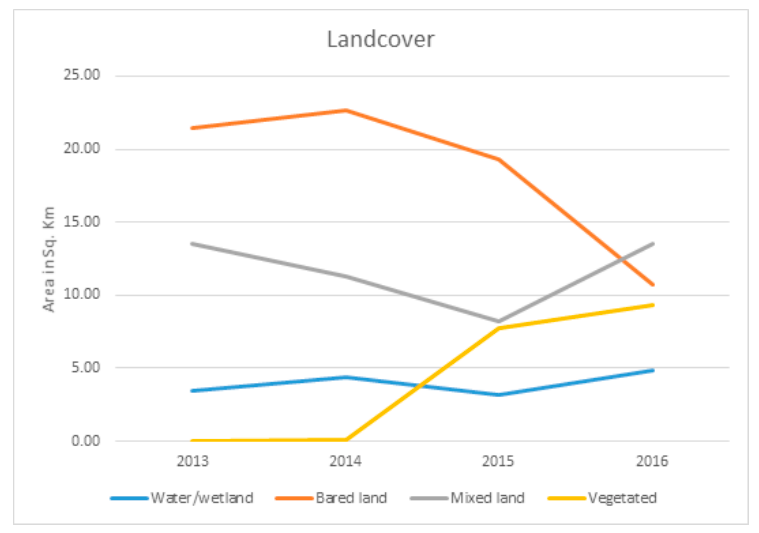
Figure 4. Changes of land cover during the study period from 2013 to 2016 in the Aso volcanic area in Japan.